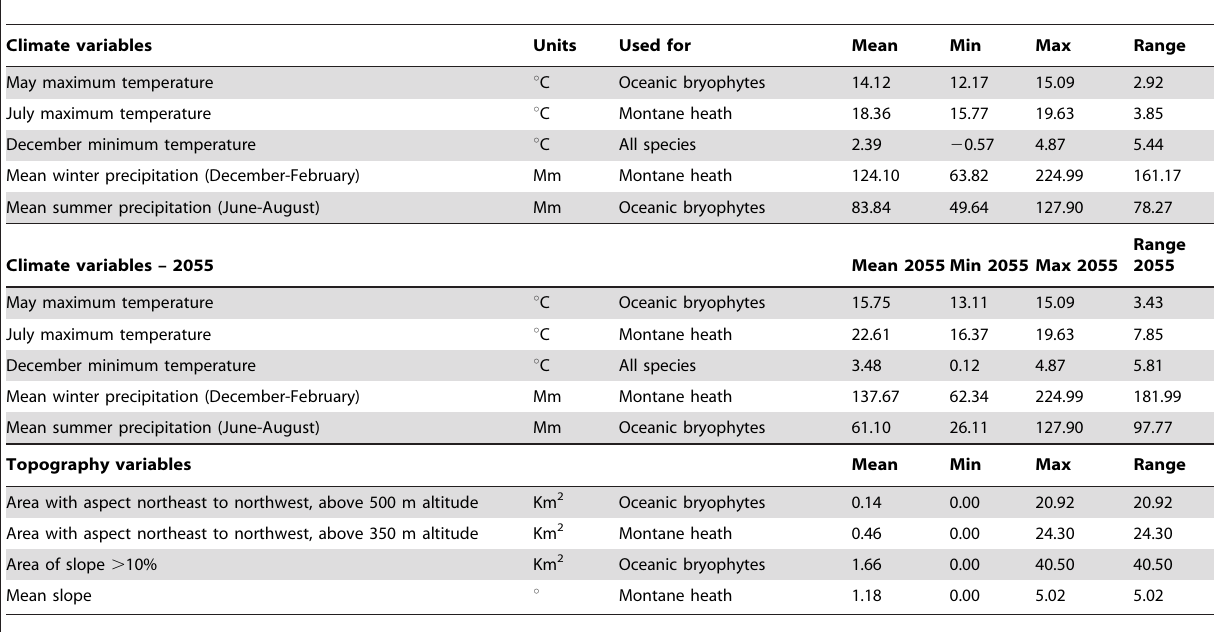
Table 1. Current mean, minimum, maximum and range values for climatic and topographic variables and projected climate variables for